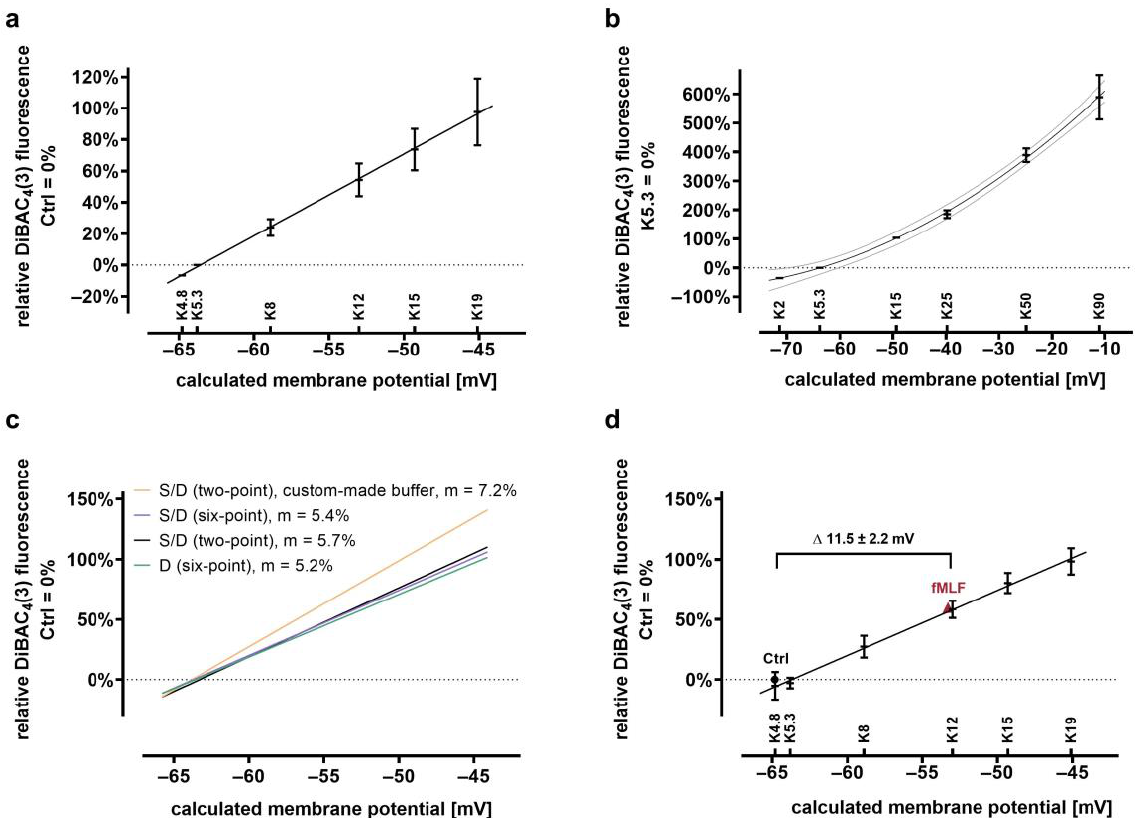
Figure 2. Summary of different calibration curves used to convert changes in DiBAC 4 (3) fluorescence into changes in MP. ( a ) Linear regression curve of DiBAC 4 (3) stained cells. Control cells in DiBAC 4 (3) stained cells in non-modified RPMI were set to 0% ( n = 3). ( b ) Non-linear regression over a wide range of potassium concentrations (2–90 mM) in custom-made buffer resembling the ion-concentration of conventional RPMI without phenol red and supplemental vitamins. Control cells in custom-made buffer with 5.3 mM potassium were set to 0% ( n = 3). ( c ) Comparison of different calibration curves. Shown are the calibration curves from ( a ) and linear regression from ( b ) with only potassium concentrations of 5.3 mM and 15 mM included. In addition, a 2-point and a 6-point calibration curve was generated from DiBAC 4 (3)-stained granulocytes in RPMI ( n = 3, m = slope). ( d ) Example of the application of the generated standard curve (S/D six-point). Cells stimulated with fMLF respond with a depolarization of 11.5 ± 2.2 mV after 1 min compared to unstimulated neutrophils. MP for Ctrl and fMLF-stimulated neutrophils was determined in standard RPMI ( n =